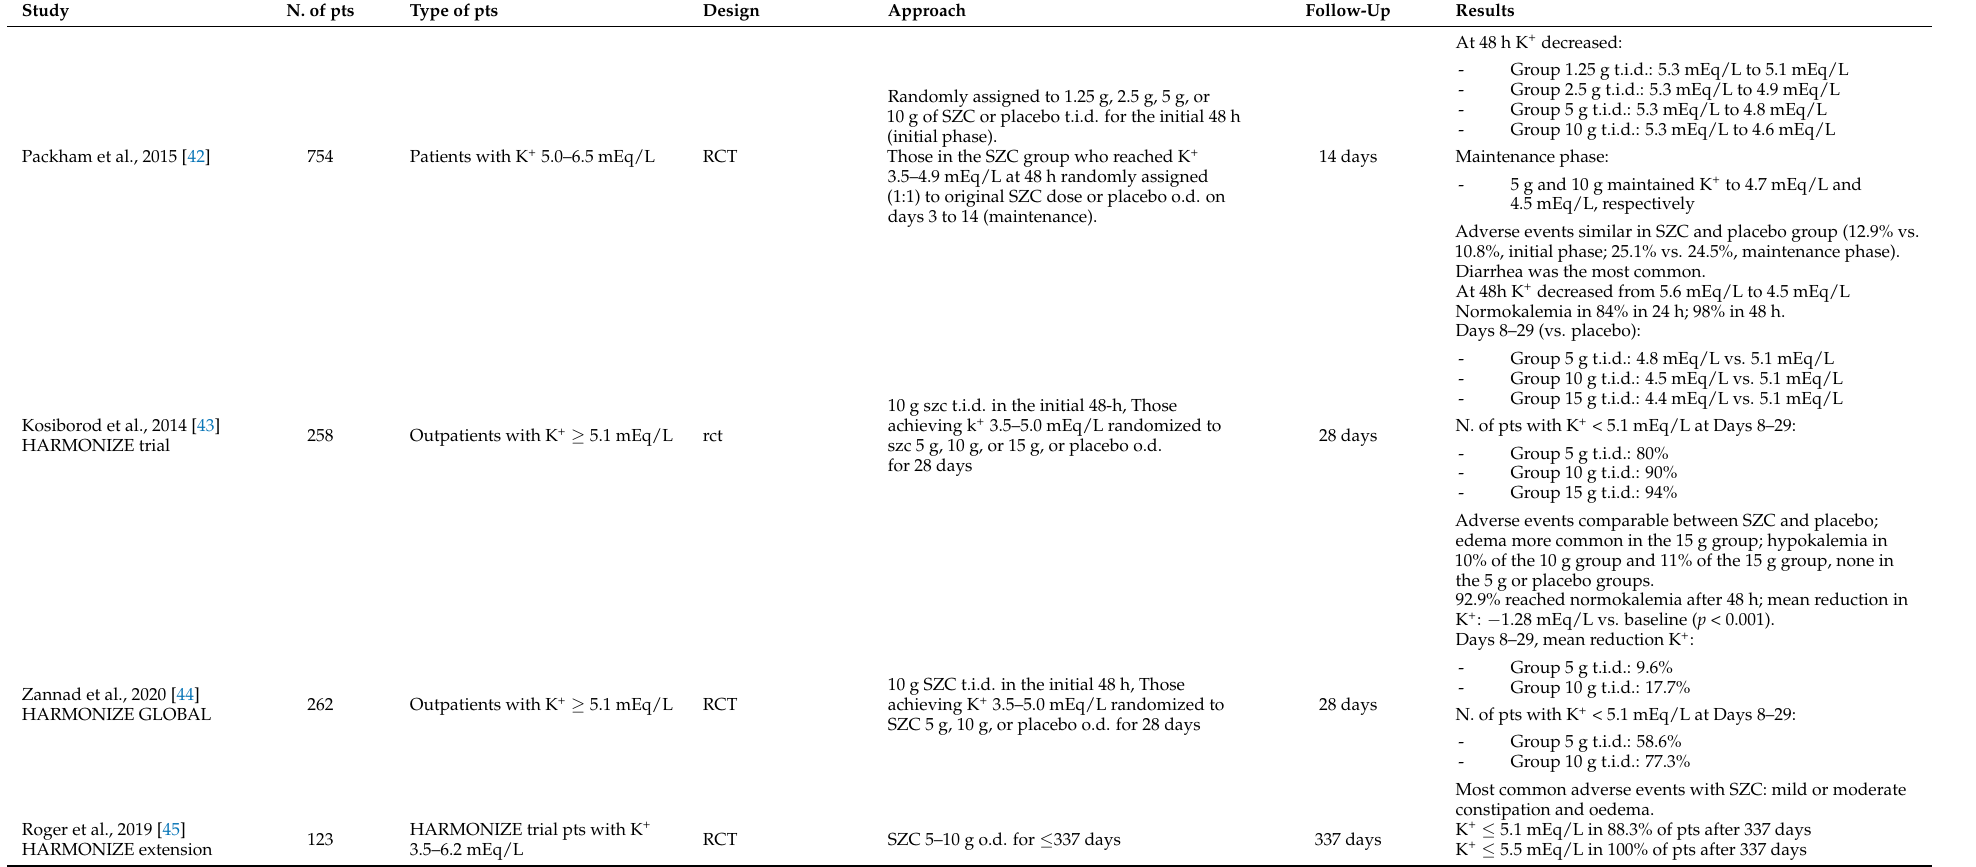
Table 3. Main characteristics of studies on sodium zirconium